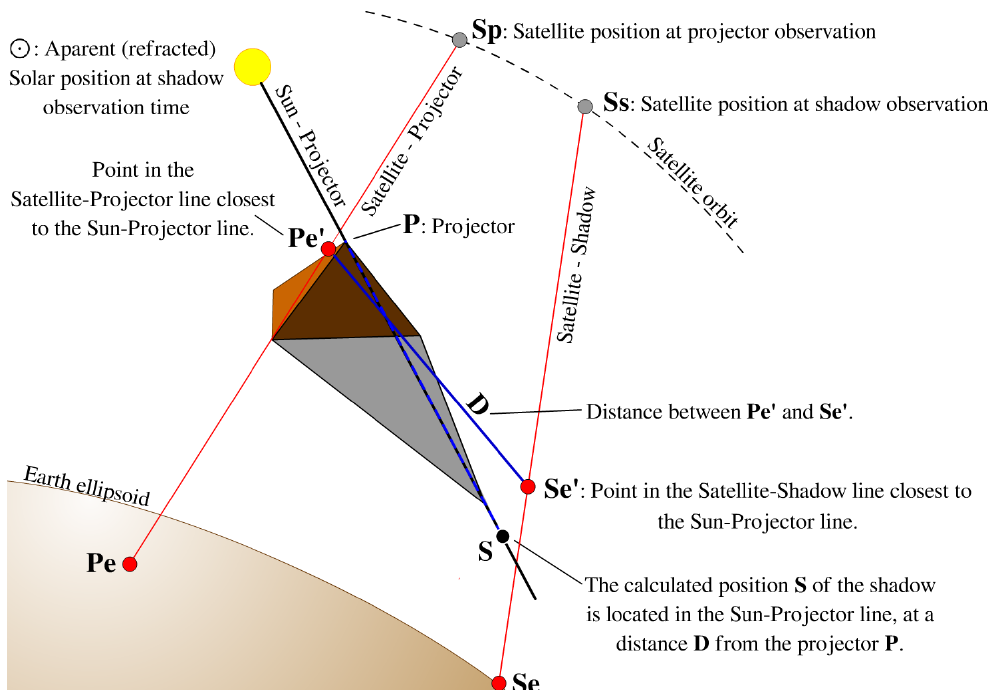
Figure 3. Schematics of the calculation process for the exact position of a